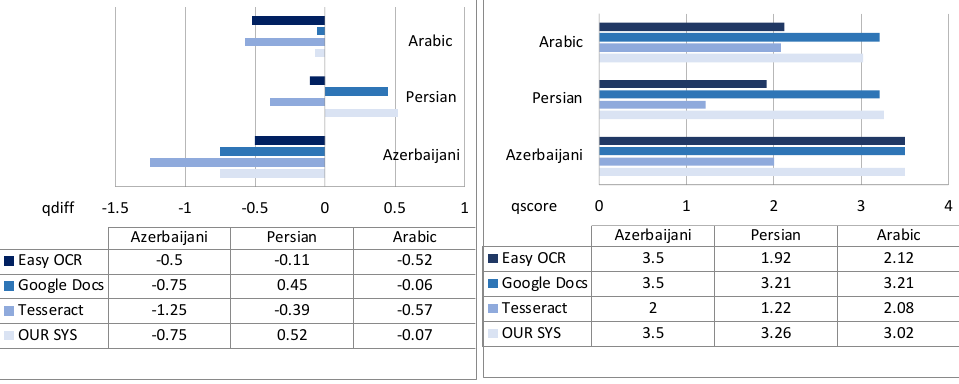
Figure 12. Text extraction: qdiff ( left ) and qscore ( right ) results per